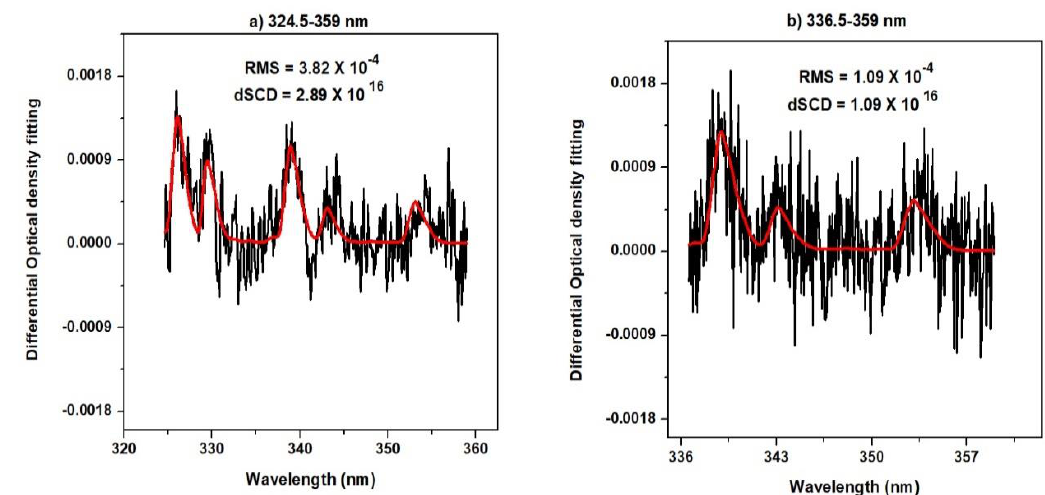
Figure 3. HCHO DOAS fit for fitting window ( a ) 324.5 – 359 nm and ( b ) 336.5 – 359 nm at 2° elevation angle. The red lines represent the fitted optical density, while measured densities are shown by the black lines.